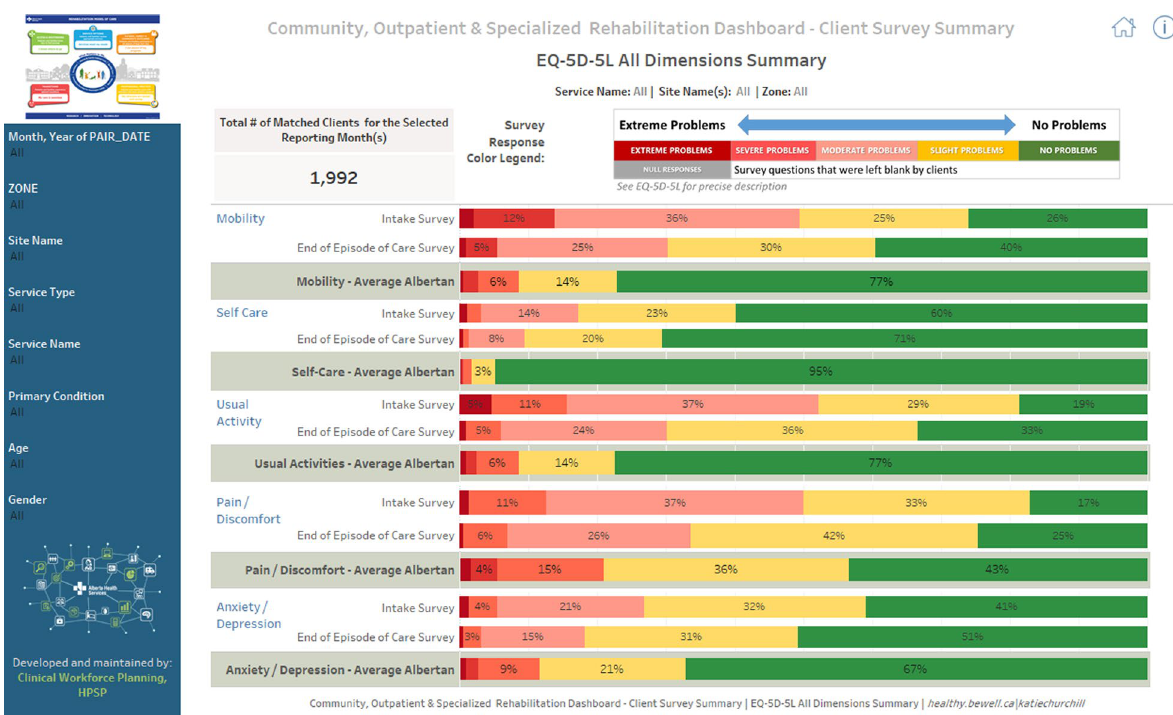
Fig. 2 AHS Tableau Dashboard for Community Rehabilitation—EQ-5D-5L Dimensions Summary view. In this figure, the distribution of the EQ-5D-5L levels across the five dimensions for 1992 patients with complete data at intake and end of episode of care ispresented, along with the general Alberta population norms data for comparative purposes. A legend for color coding for the levels is also provided for ease ofinterpretation. Dashboard data is from December 2018–October